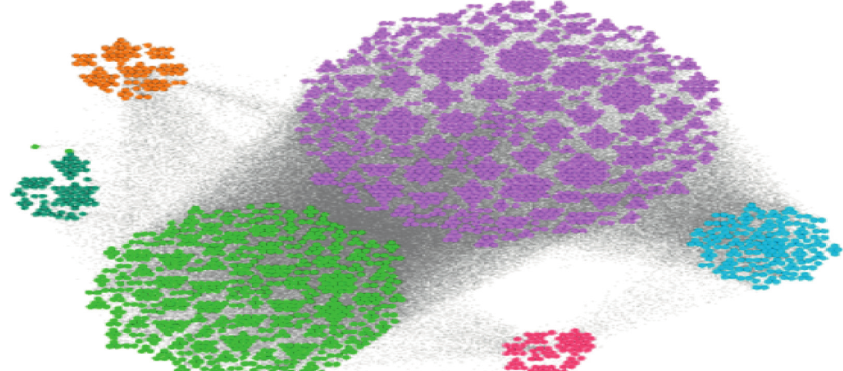
Figure 8: Clustering results based on Movielens-100k .